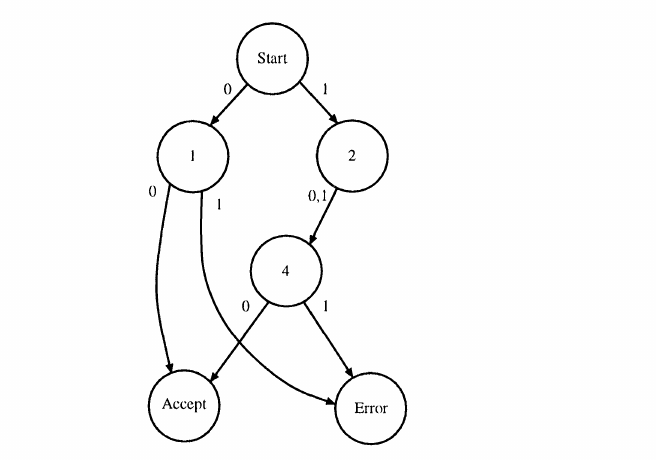
FIGURE 9 Partially reduced finite state machine recognizing the language {000, 001, 100, 110}.